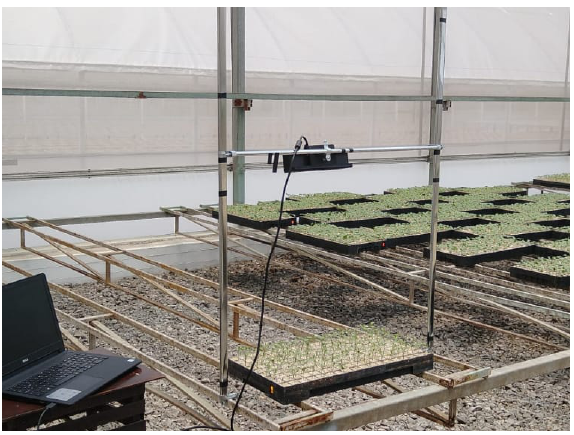
Figure 1. ScanSeedling v1.0 Prototype showing a scan of a rigid plastic